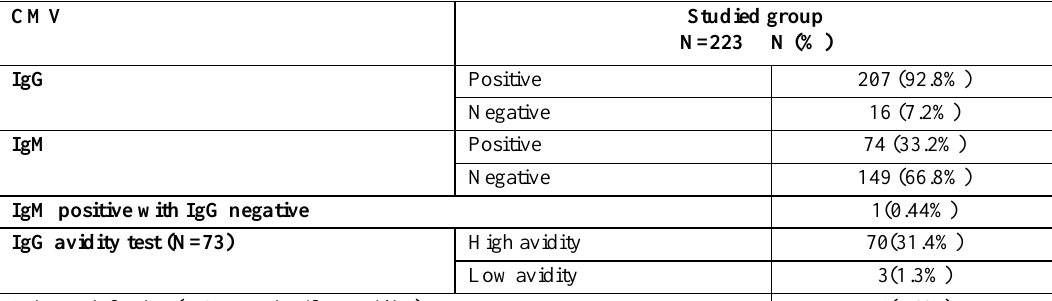
Table 2. Frequency of positive CMV IgG, IGM, and IgG